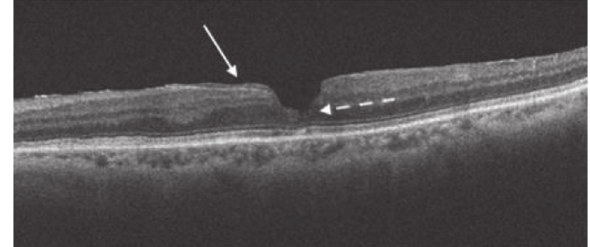
Figure 3: SD-OCTscan of a lamellar macular hole. In this scan, the white arrow shows the presence of the iso-reflective epiretinal proliferation. The dashed white arrow highlights the irregular foveal contour and the initial disruption of outer retinal layers, especially external limiting membrane and ellipsoid